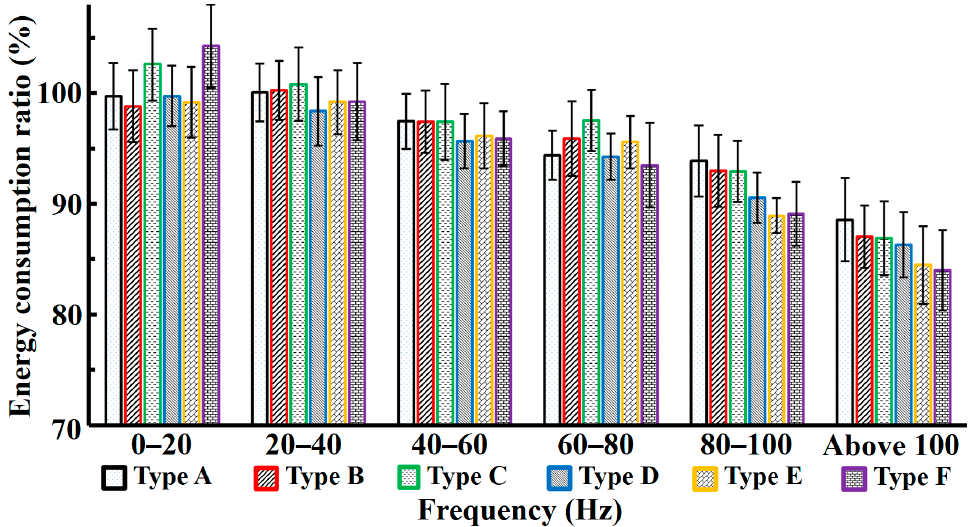
Figure 14. The ratio of forced vibration subsoiling total energy consumption to non-vibration energy consumption at 5 km/h speed.